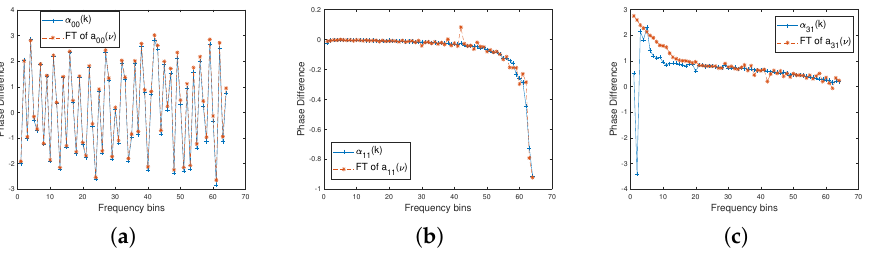
Figure 7. Phase difference comparison between the Fourier Transform of the time domain spherical harmonic coefficients a nm ( ν ) and frequency domain spherical harmonic coefficients α nm ( k ) at mode ( a ) 00, ( b ) 11 and ( b ) 31 with a white Gaussian noise.